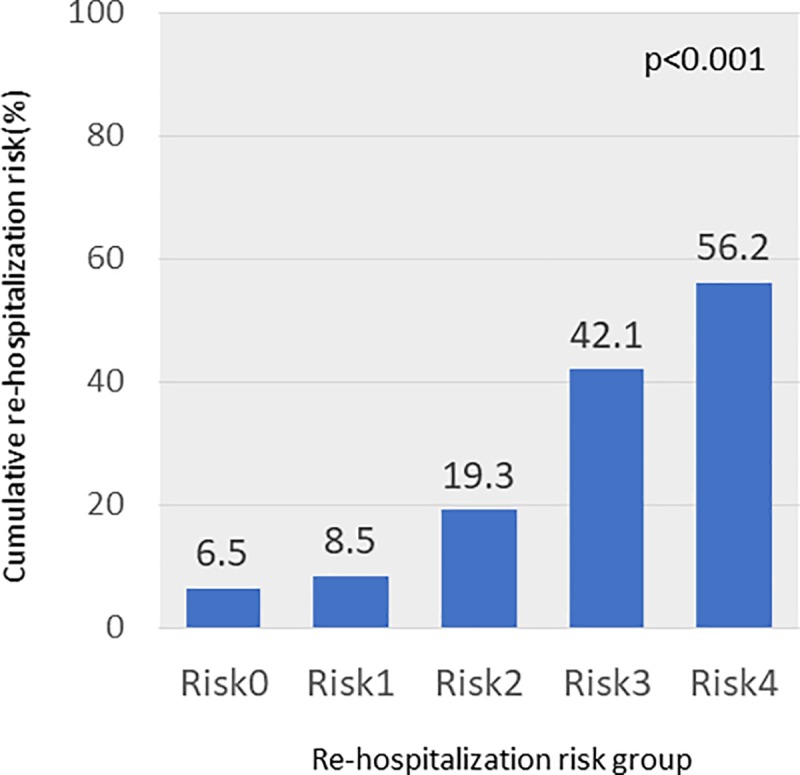
Cumulative re-hospitalization risk.Rates of re-hospitalization for congestive heart failure in the validation subset based on their risk score.